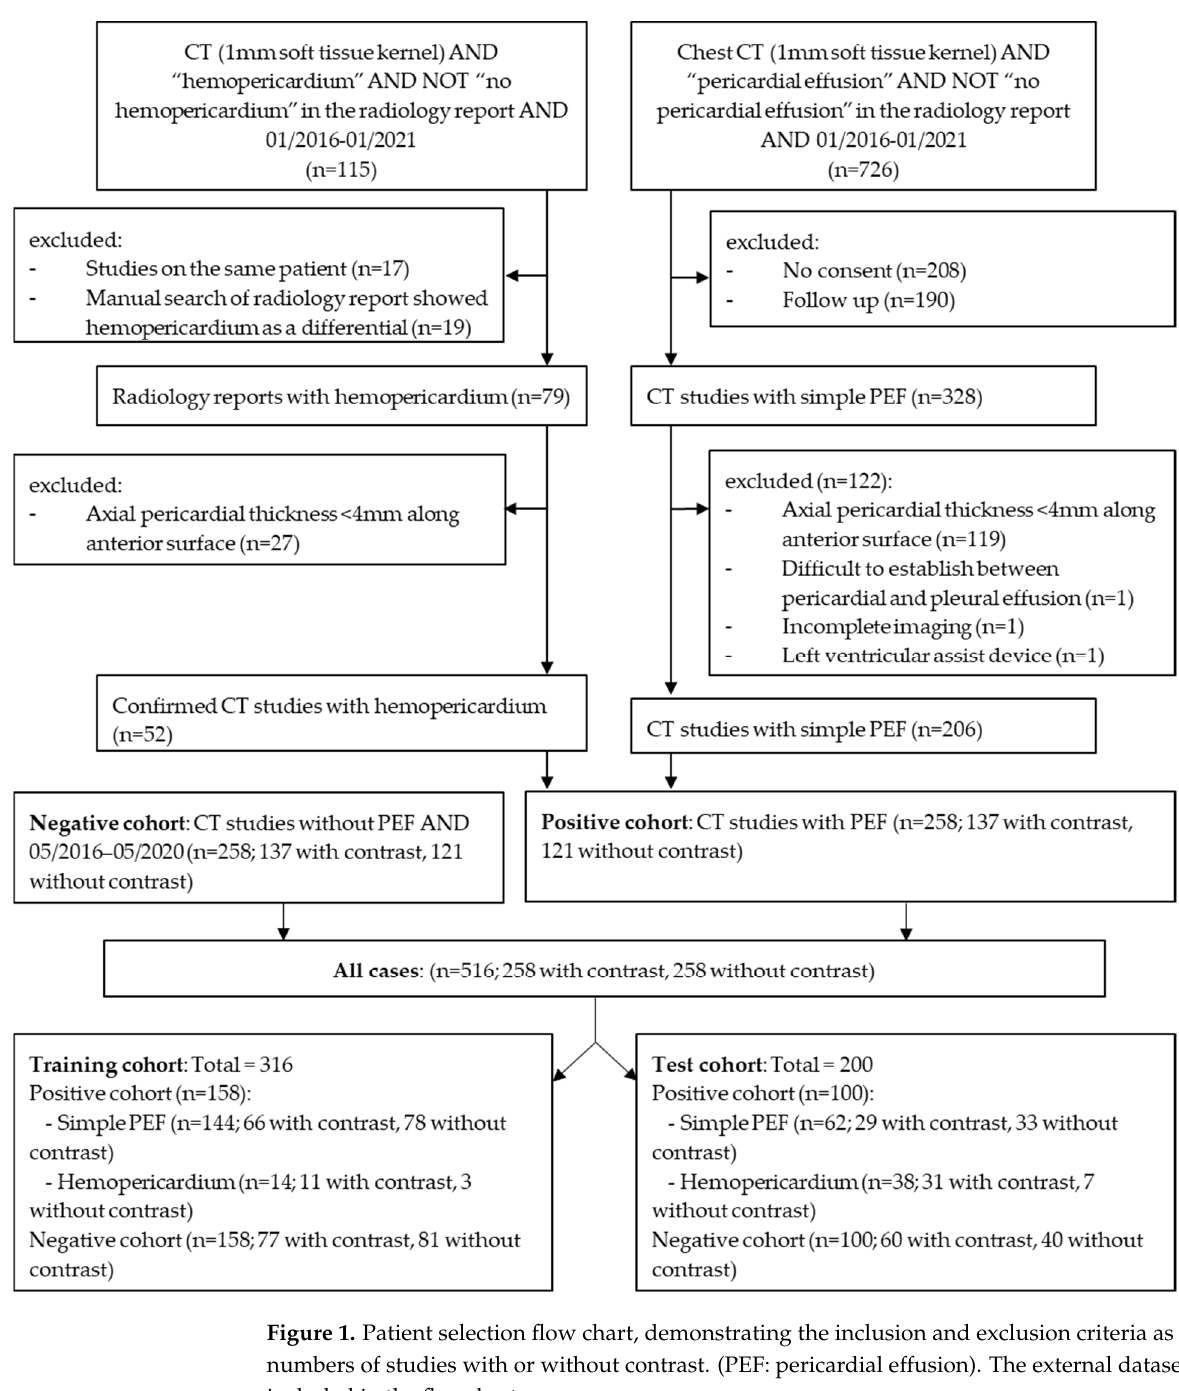
Figure 1. Patient selection flow chart, demonstrating the inclusion and exclusion criteria as well as numbers of studies with or without contrast. (PEF: pericardial effusion). The external dataset is not included in the flowchart.